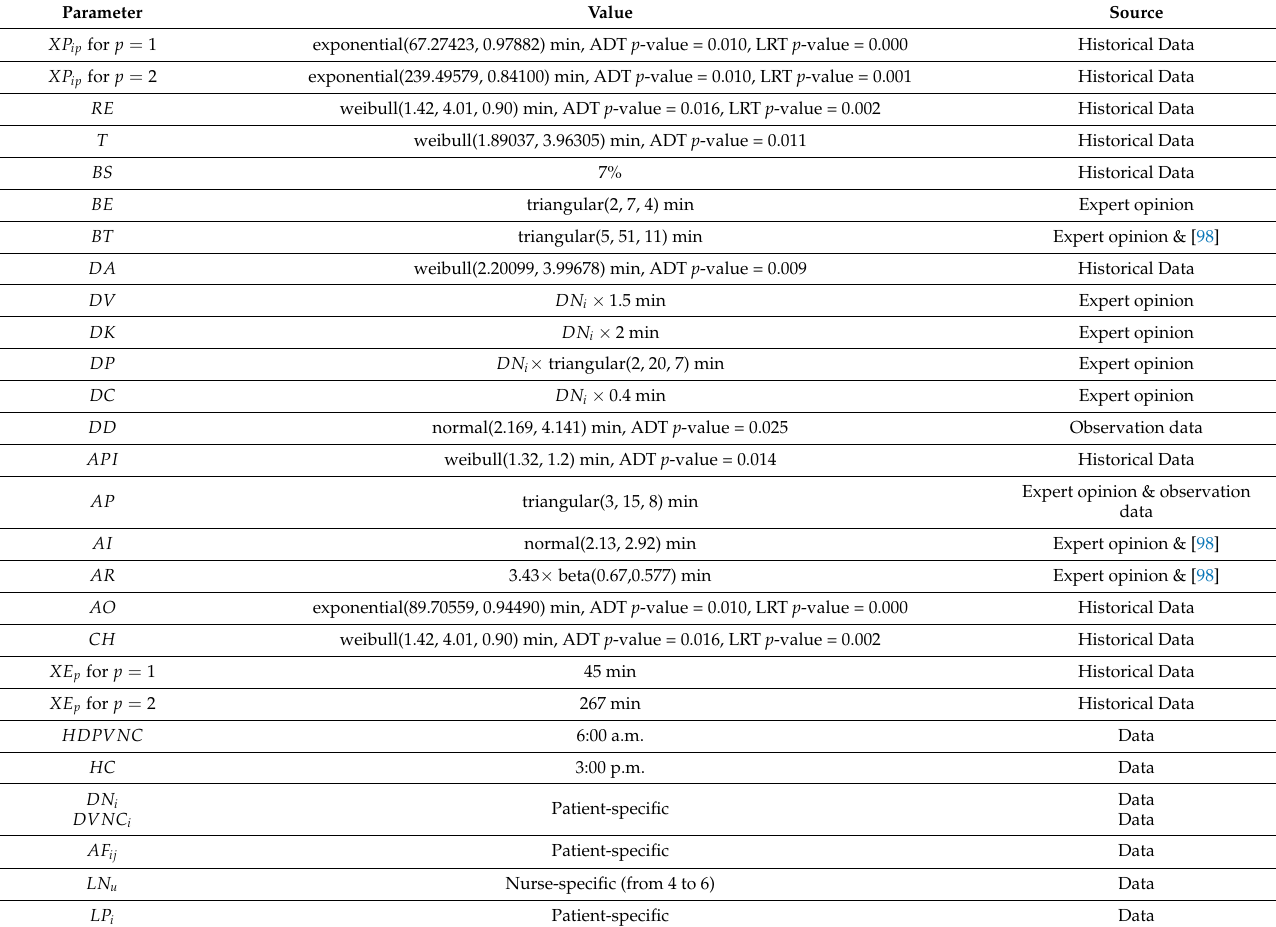
Table A2. Values of the stochastic simulation model parameters used in the model validation and the experimental